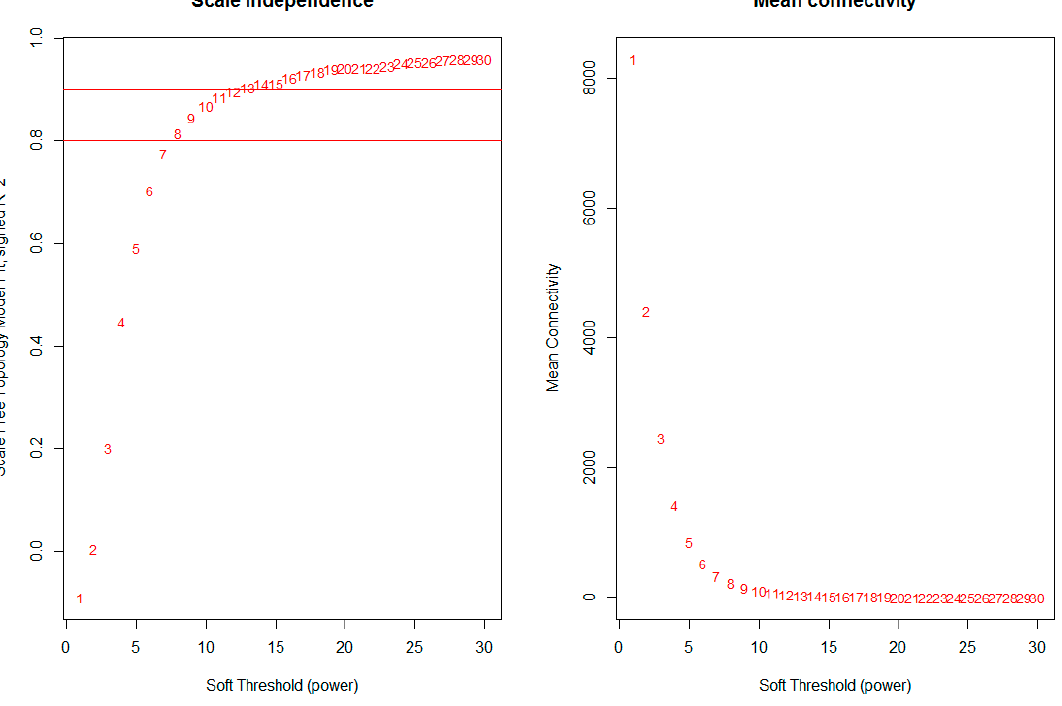
Figure 1. Network topology for different soft-thresholding powers. Numbers in the plots indicate the corresponding soft thresholding powers. The approximate scale-free topology can be attained at the soft-thresholding power of 8.